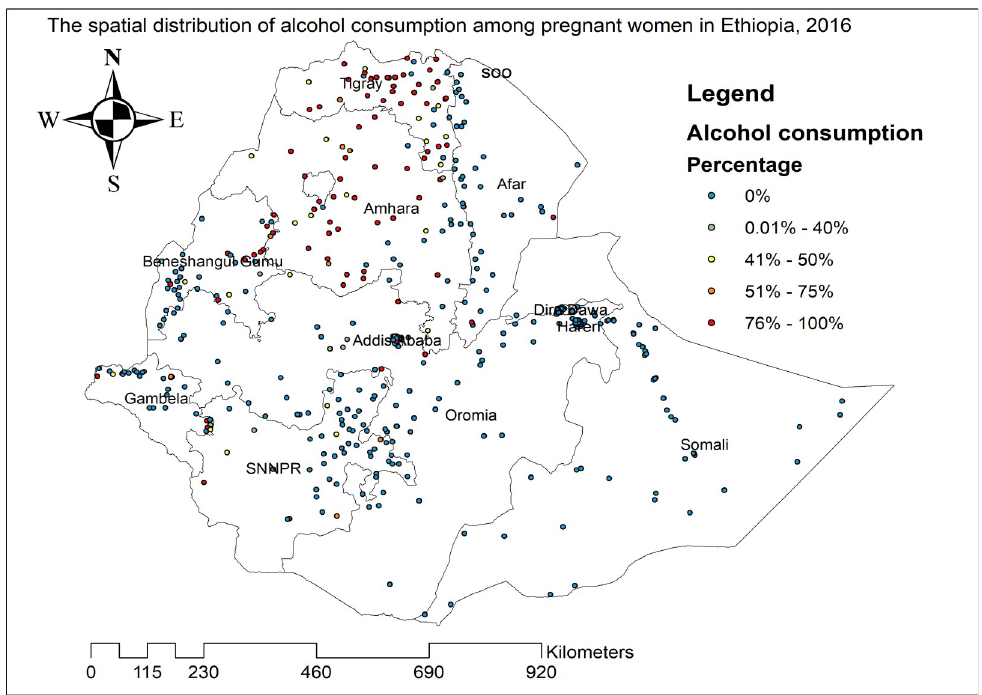
Fig 2. Spatial distribution of alcohol consumption among pregnant women across regions in Ethiopia,